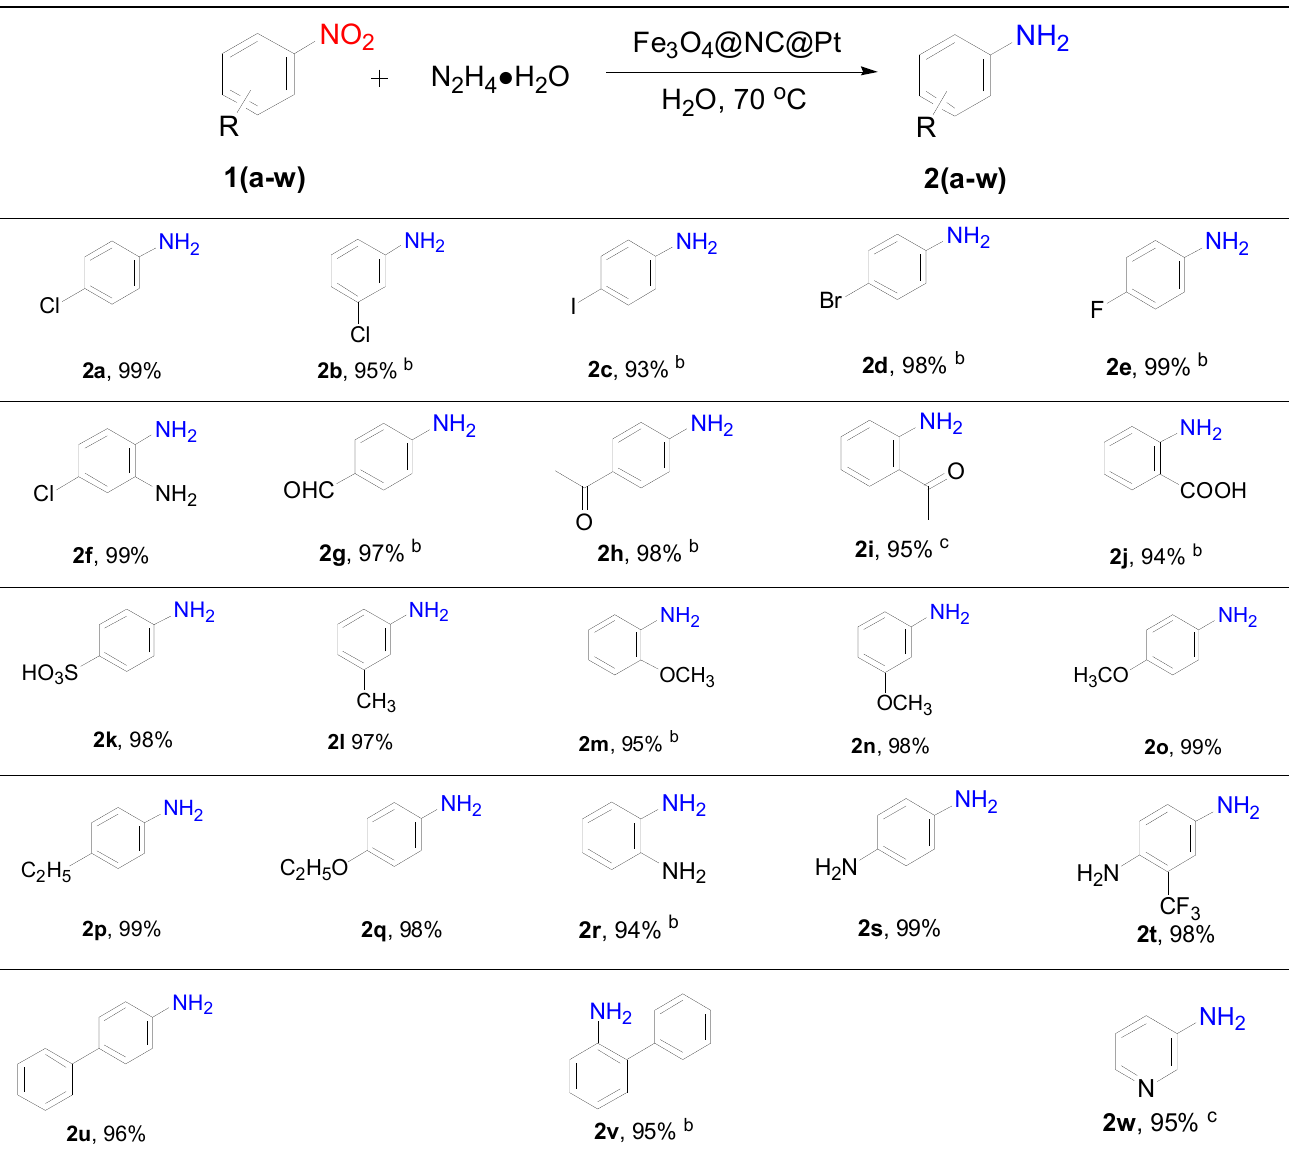
air, isolated yield; b 8 h; c 16 h.